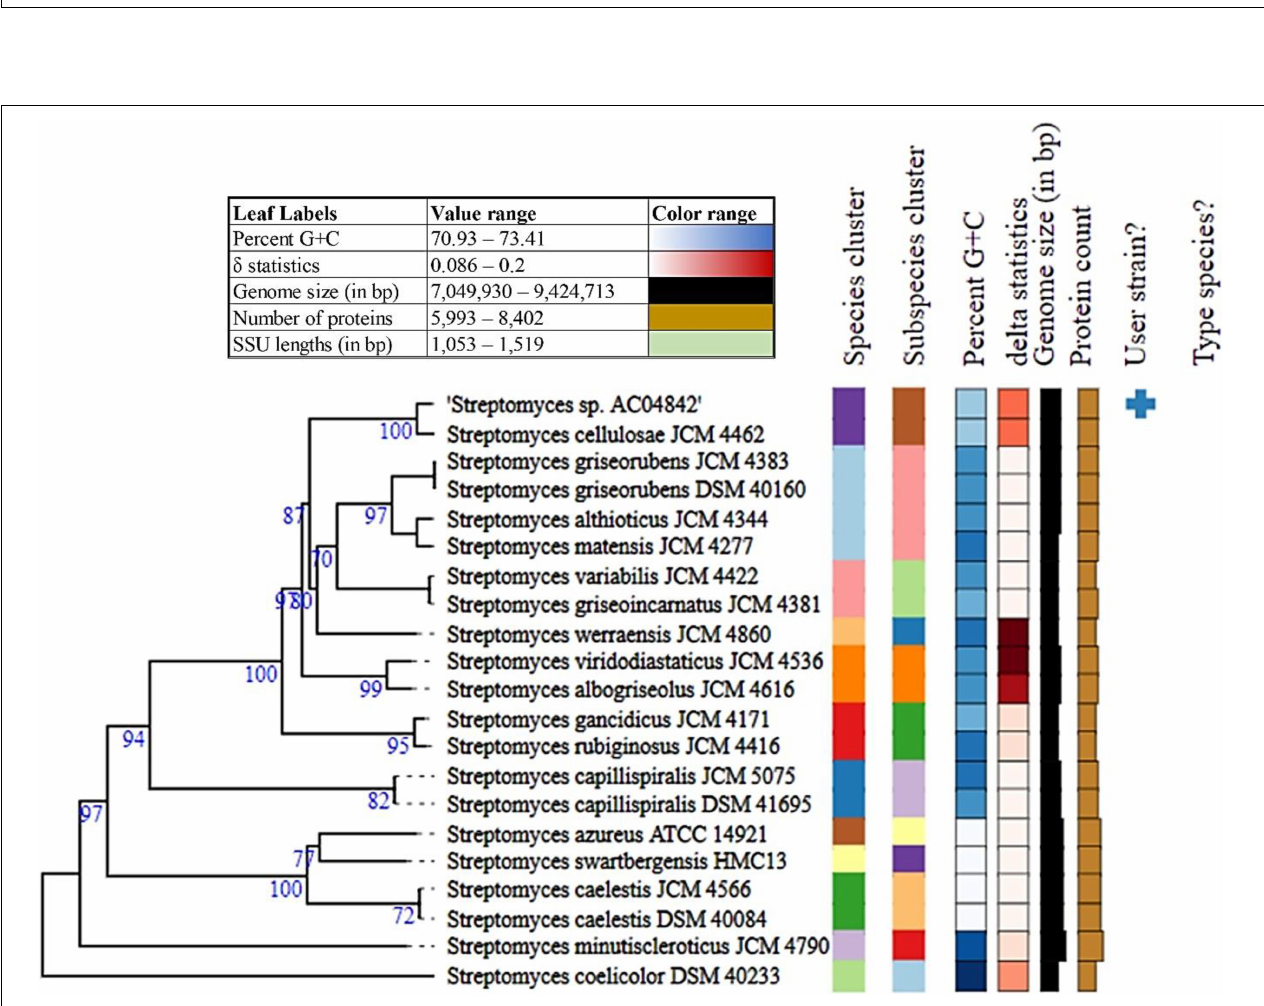
FIGURE 2 | Phylogenetic analysis of Streptomyces sp. AC04842 draft genome with other closely related Streptomyces strains genomes using TYGS analysis. Tree inferred with FastME 2.1.6.1 (Lefort et al., 2015) from GBDP distances calculated from genome sequences. The branch lengths are scaled in terms of GBDP distance formula d5. The numbers above branches are GBDP pseudo-bootstrap support values > 60.00% from 100 replications, with an average branch support of 83.30%. The tree was rooted at the midpoint (Farris, 1972).